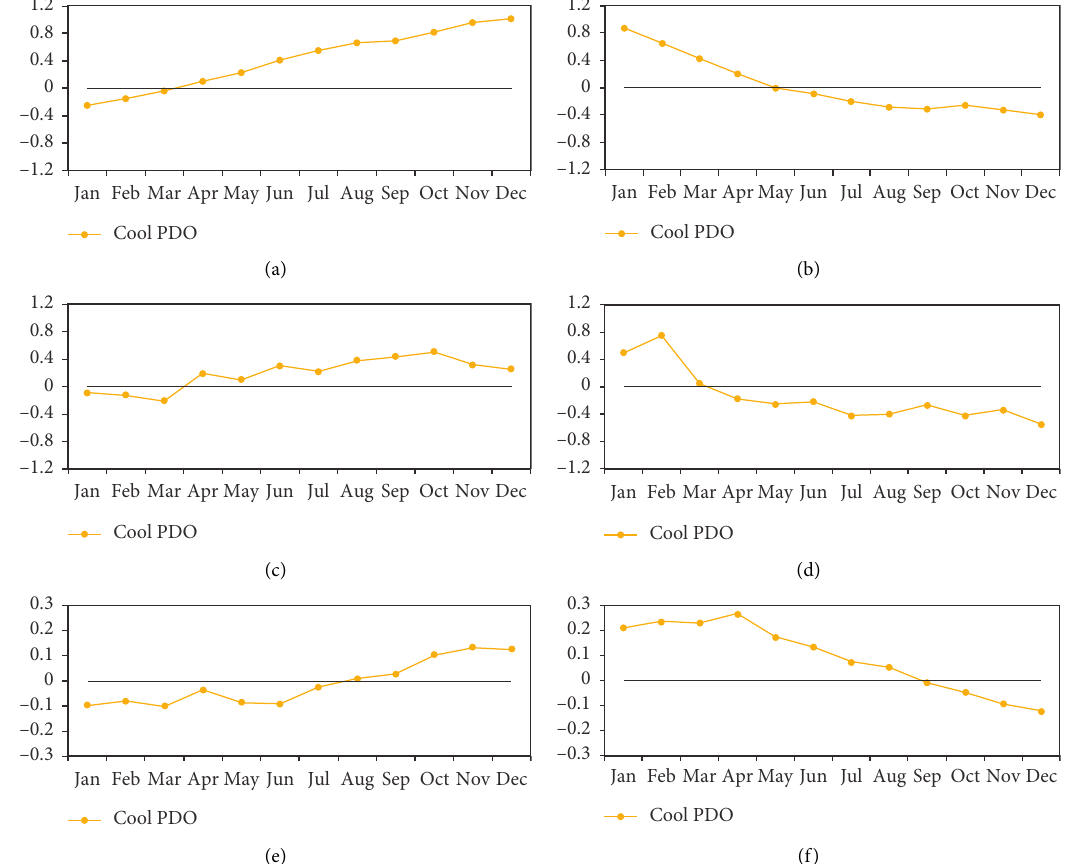
Figure 8: Monthly averaged ((a) and (b)) SST anomalies over the central-eastern equatorial Pacific (5 ° S–5 ° N, 180 ° –90 ° W), ((c) and (d)) 850hPa zonal wind anomalies over the equatorial Pacific (10 ° S–10 ° N, 140 ° E–120 ° W), and ((e) and (f)) SSTanomalies over the north Indian Ocean in the cool PDO phase. (a) Developing period, central-eastern Pacific SST. (b) Decaying period, central-eastern Pacific SST. (c) Developing period, zonal wind. (d) Decaying period, zonal wind. (e) Developing period, north Indian Ocean SST. (f) Decaying period, north Indian Ocean